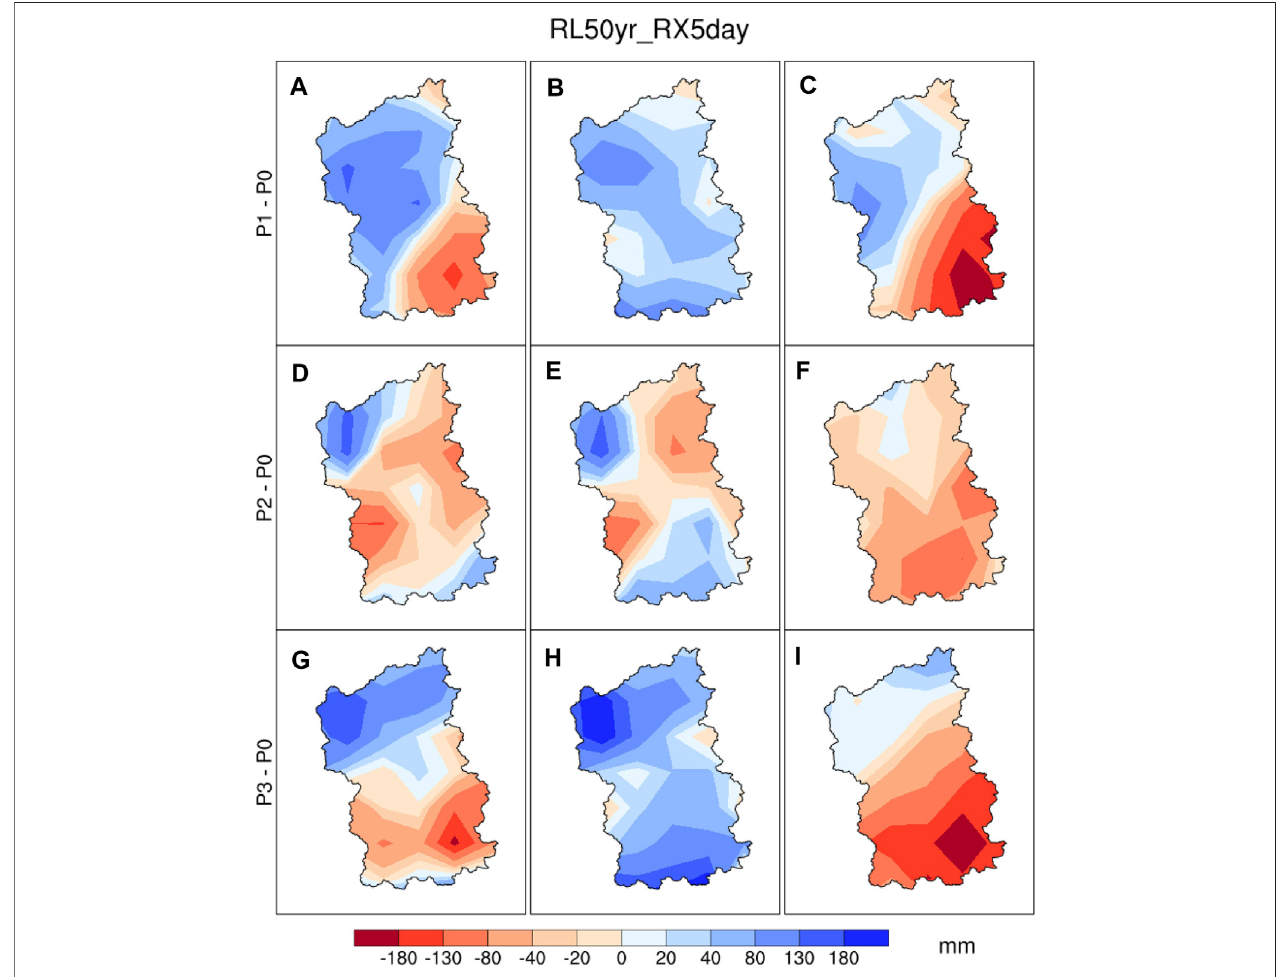
FIGURE 7 | Spatial distribution of the projected changes in 50-year return levels (mm) of RX5day under the RCP4.5 for (A) the entire rainy season, (B) the fi rst-half rainy season, and (C) the second-half rainy season during P1 (2021 – 2040) relative to present-day P0 (1986 – 2005). (D – F) and (G,H) are the same as (A – C) , but for changes during P2 (2041 – 2060) and during P3 (2081 – 2098)